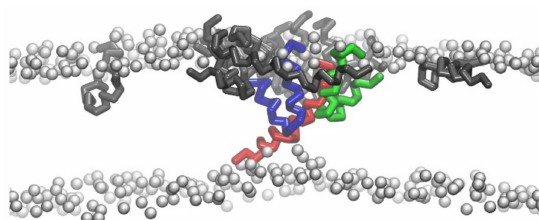
Figure 3. Aggregation and conformational change of melittin during insertion into a DLPC membrane. Peptides have various conformations and states, including U-shaped conformation (blue and green) and transmembrane insertion state (red). The other peptides are shown in black, while the lipid headgroups are shown as silver-grey beads. For clarity, the lipid tails are not